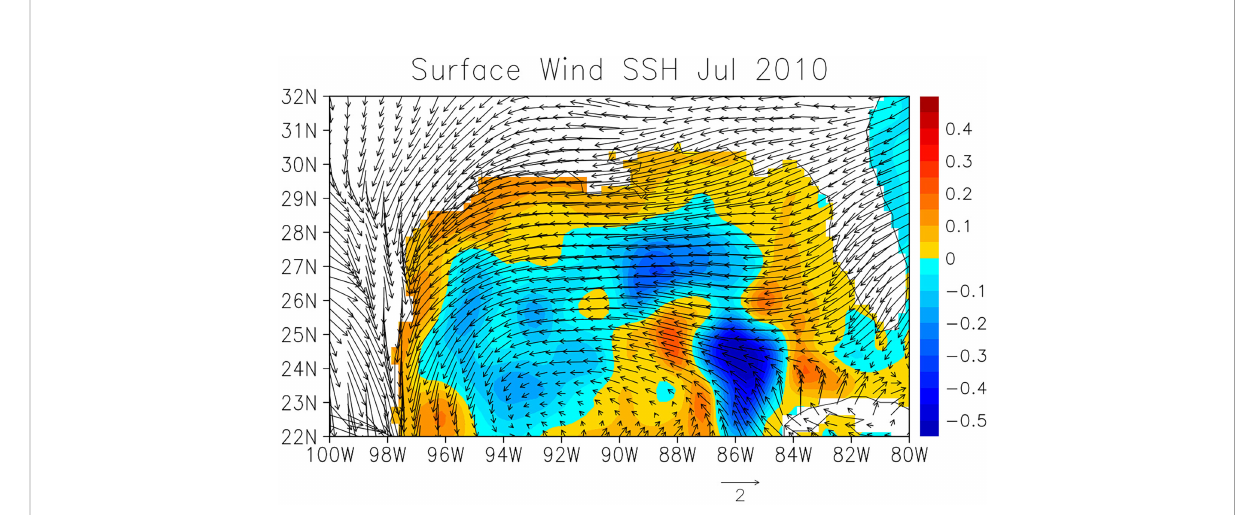
FIGURE 10 Anomalies of surface winds (arrows) and SSH (shading) from AVISO in July